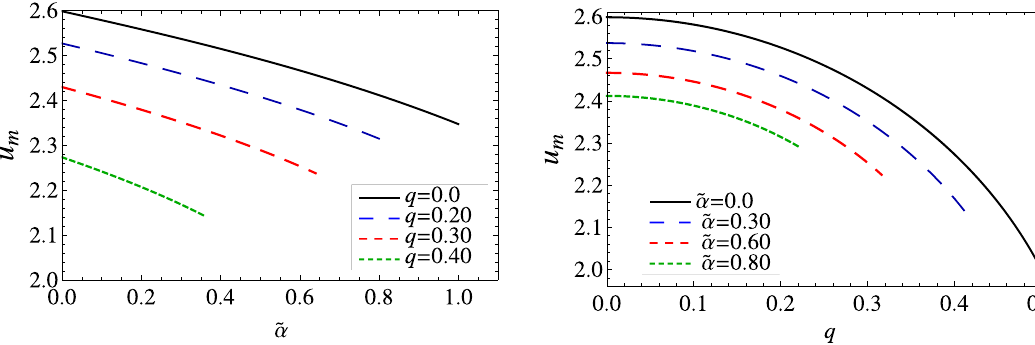
Fig. 5 Plot showing the impact parameter u m for photon circular orbits with q and ˜ α